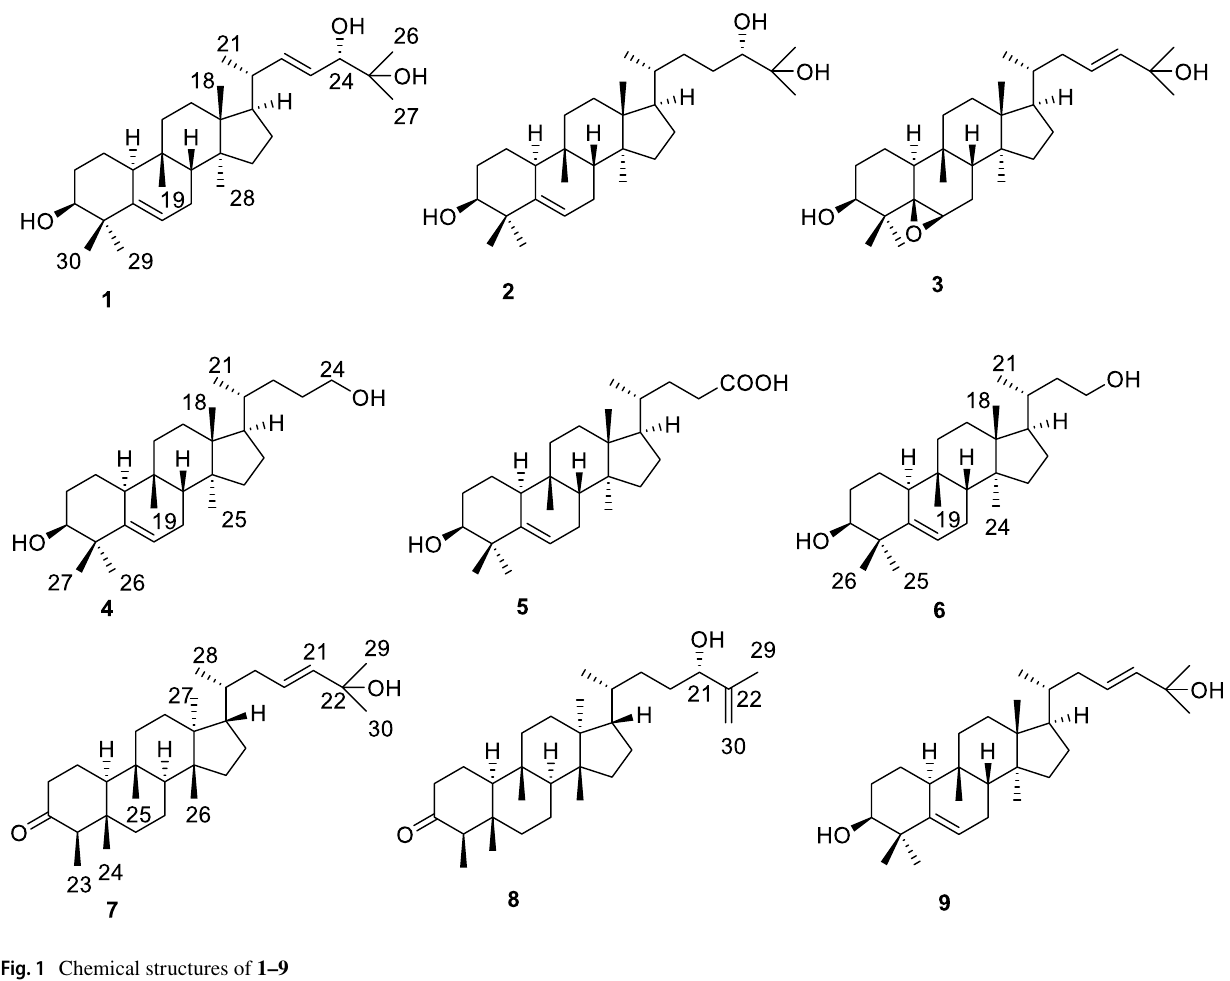
Fig. 1 Chemical structures of